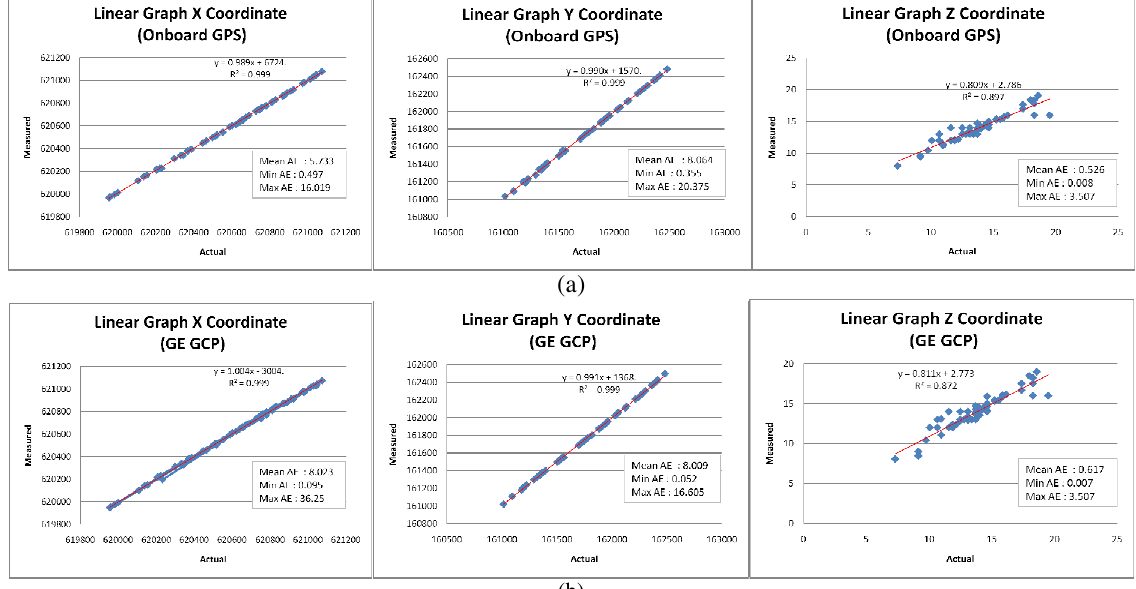
Figure 5. (a) Linear graph X, Y, Z coordinates for GPS onboard; (b) Linear graph X, Y, Z coordinate for Google Earth (GE)